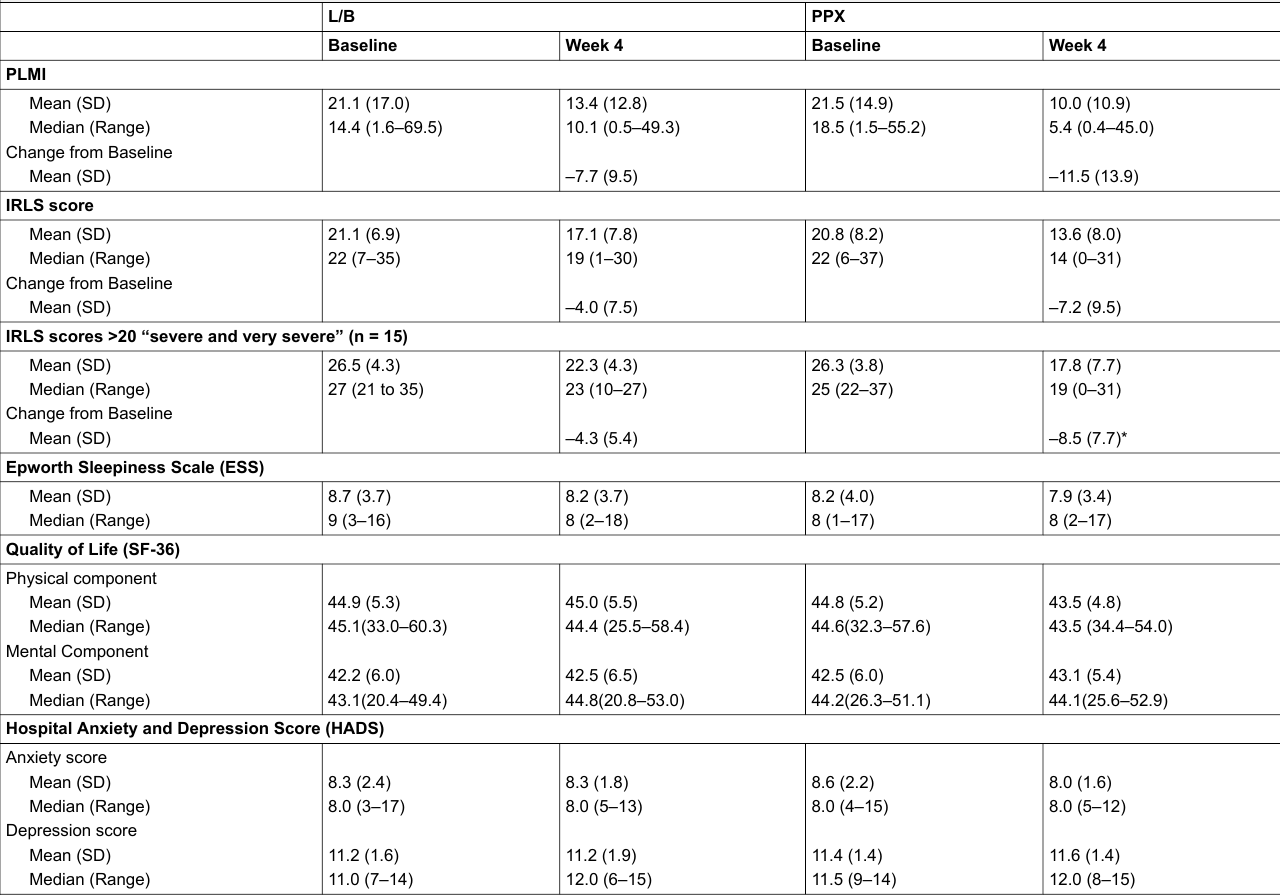
Table 1: Treatment effects on primary and secondary outcome measures in PP population (n = 39). L/B PPX Baseline Week 4 Baseline Week 4